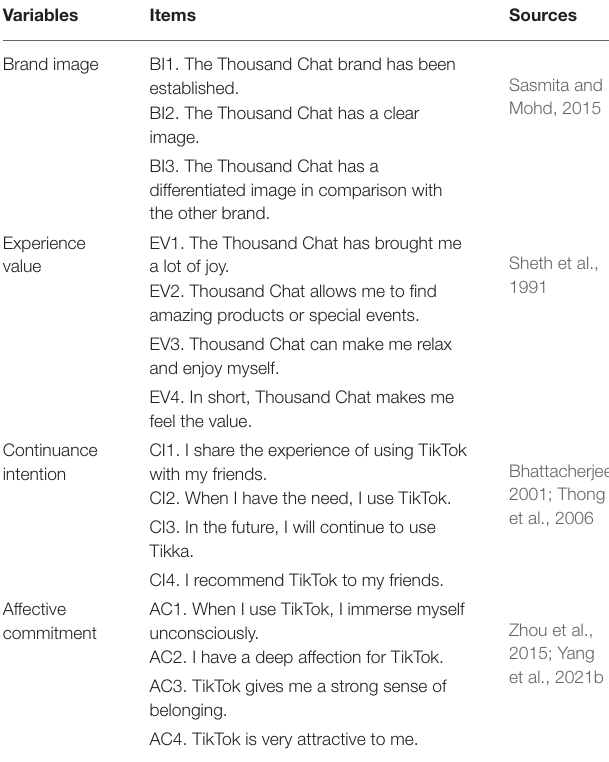
TABLE 1 | Variables and measurement